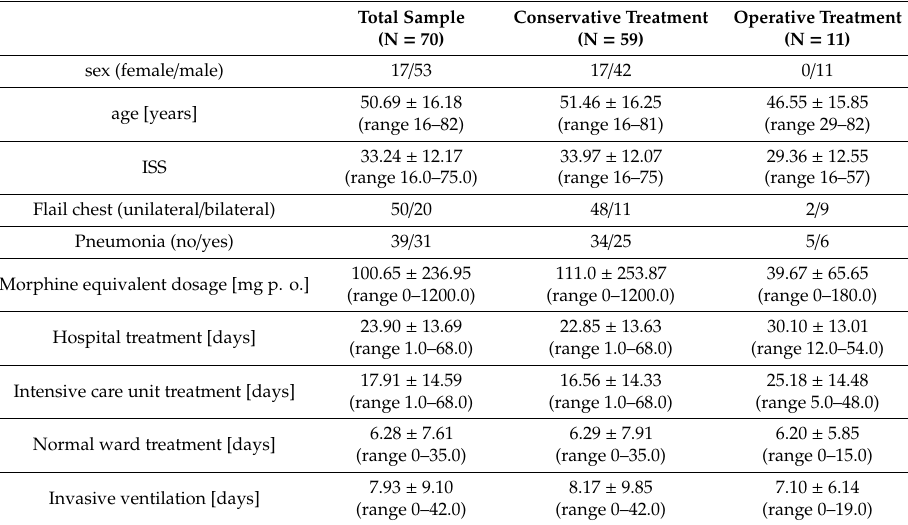
Table 1. Demographic overview of the study